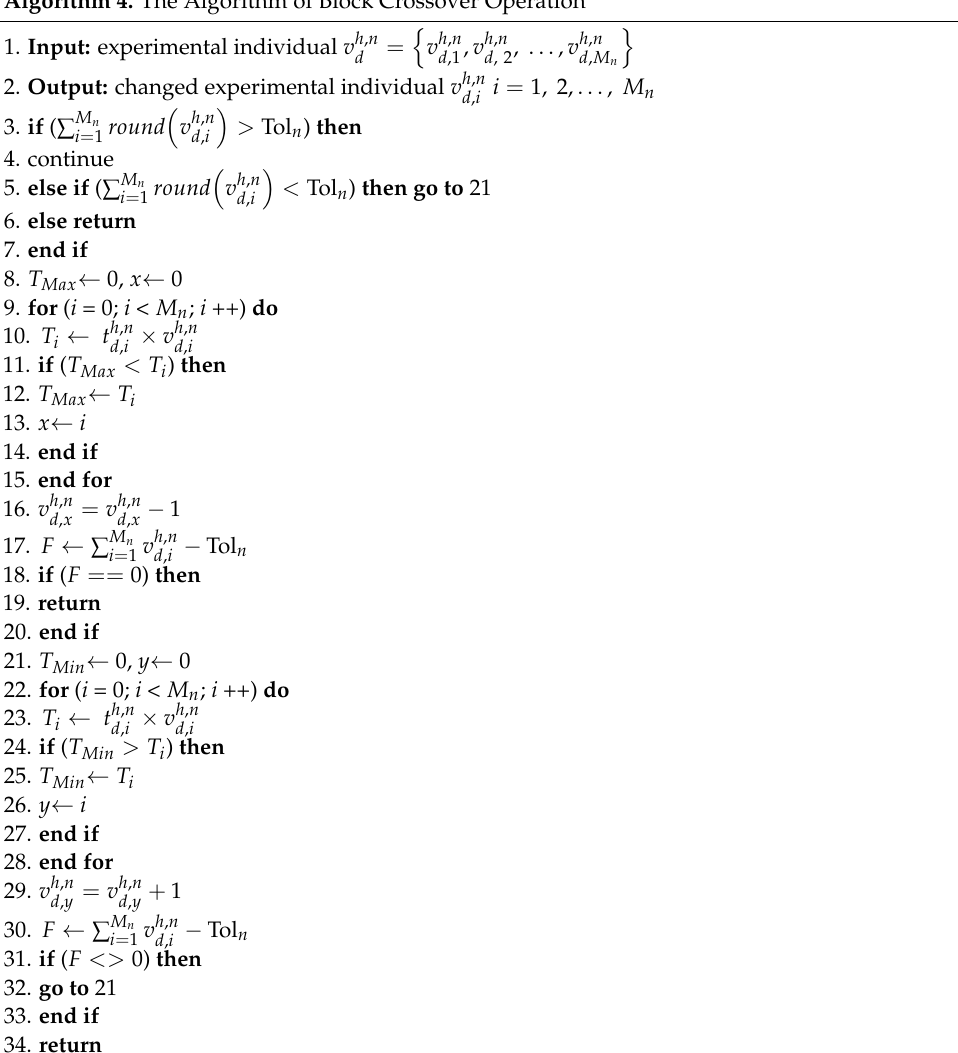
Algorithm 4. The Algorithm of Block Crossover